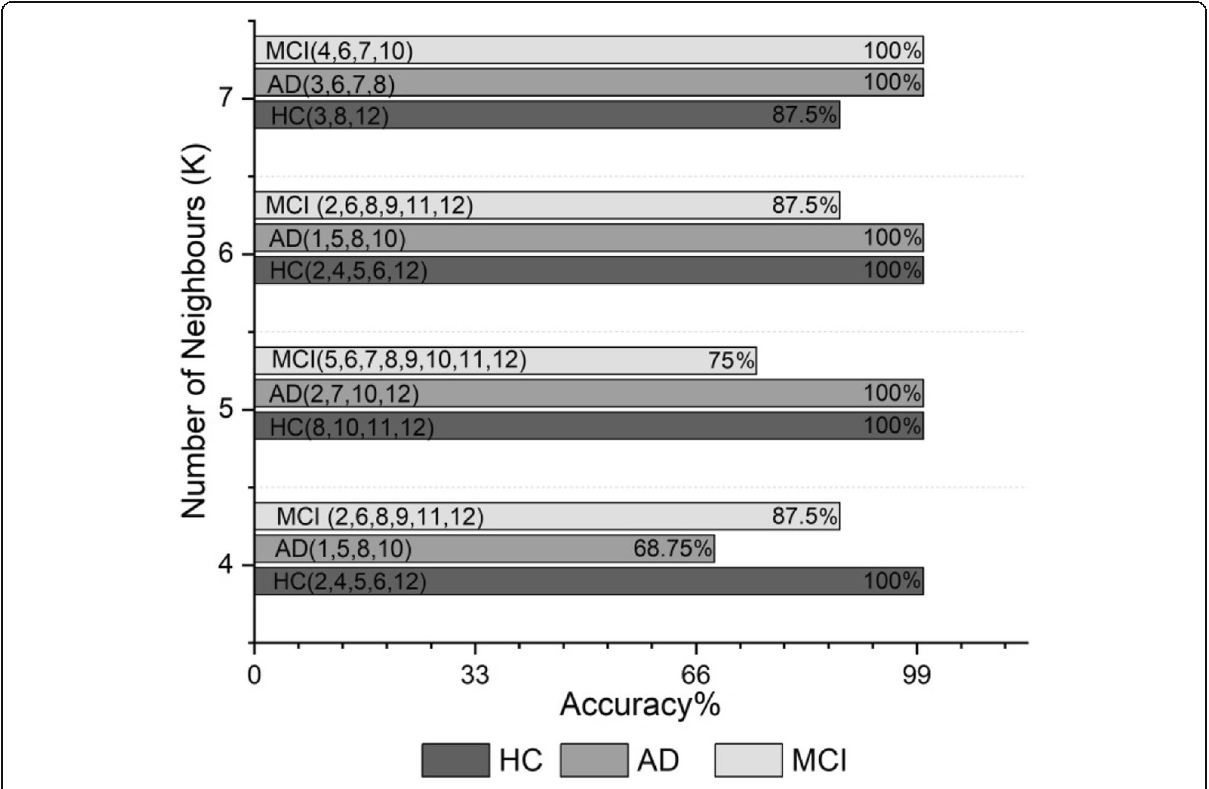
Fig. 1 KNN accuracies for K = 4, 5, 6, 7